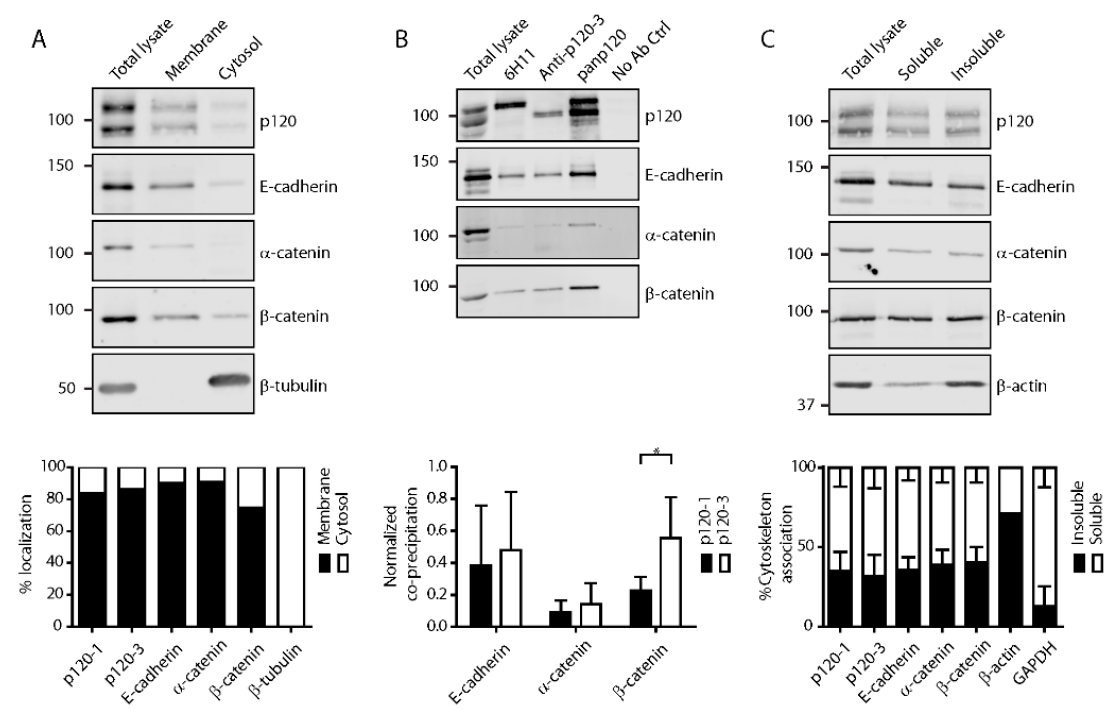
Figure 2. P120 isoform association with adherens junctions in 4T1 cells. ( A ) Membrane–cytosol fractionation. ( B ) Co-immunoprecipitation with isoform-specific antibodies for P120-1 (6H11 mAb) and P120-3 (anti-P120-3 pAb). IP antibodies are indicated above the blots (* p < 0.05). ( C ) Cytosol extraction. All membranes were incubated with the antibodies indicated adjacent to the blots. In the blots stained for P120, the upper band represents P120-1 and the lower band represents P120-3. Quantifications are shown in bar graphs below the blots.